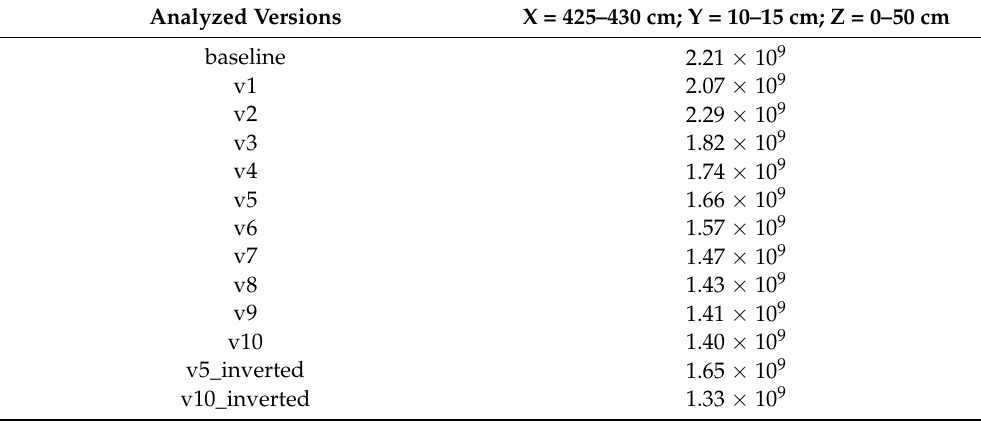
Table 3. Neutron flux (n/cm 2 /s) at first 5 cm of TFC for the baseline model, versions v1–v10, and v5_inverted and